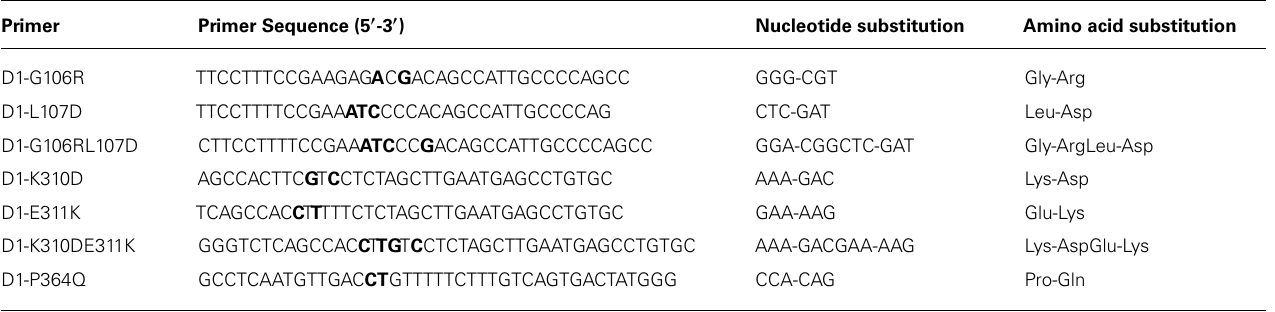
GCCTCAATGTTGAC CT GTTTTTCTTTGTCAGTGACTATGGG CCA-CAG Pro-Gln Mutated nucleotides are shown in